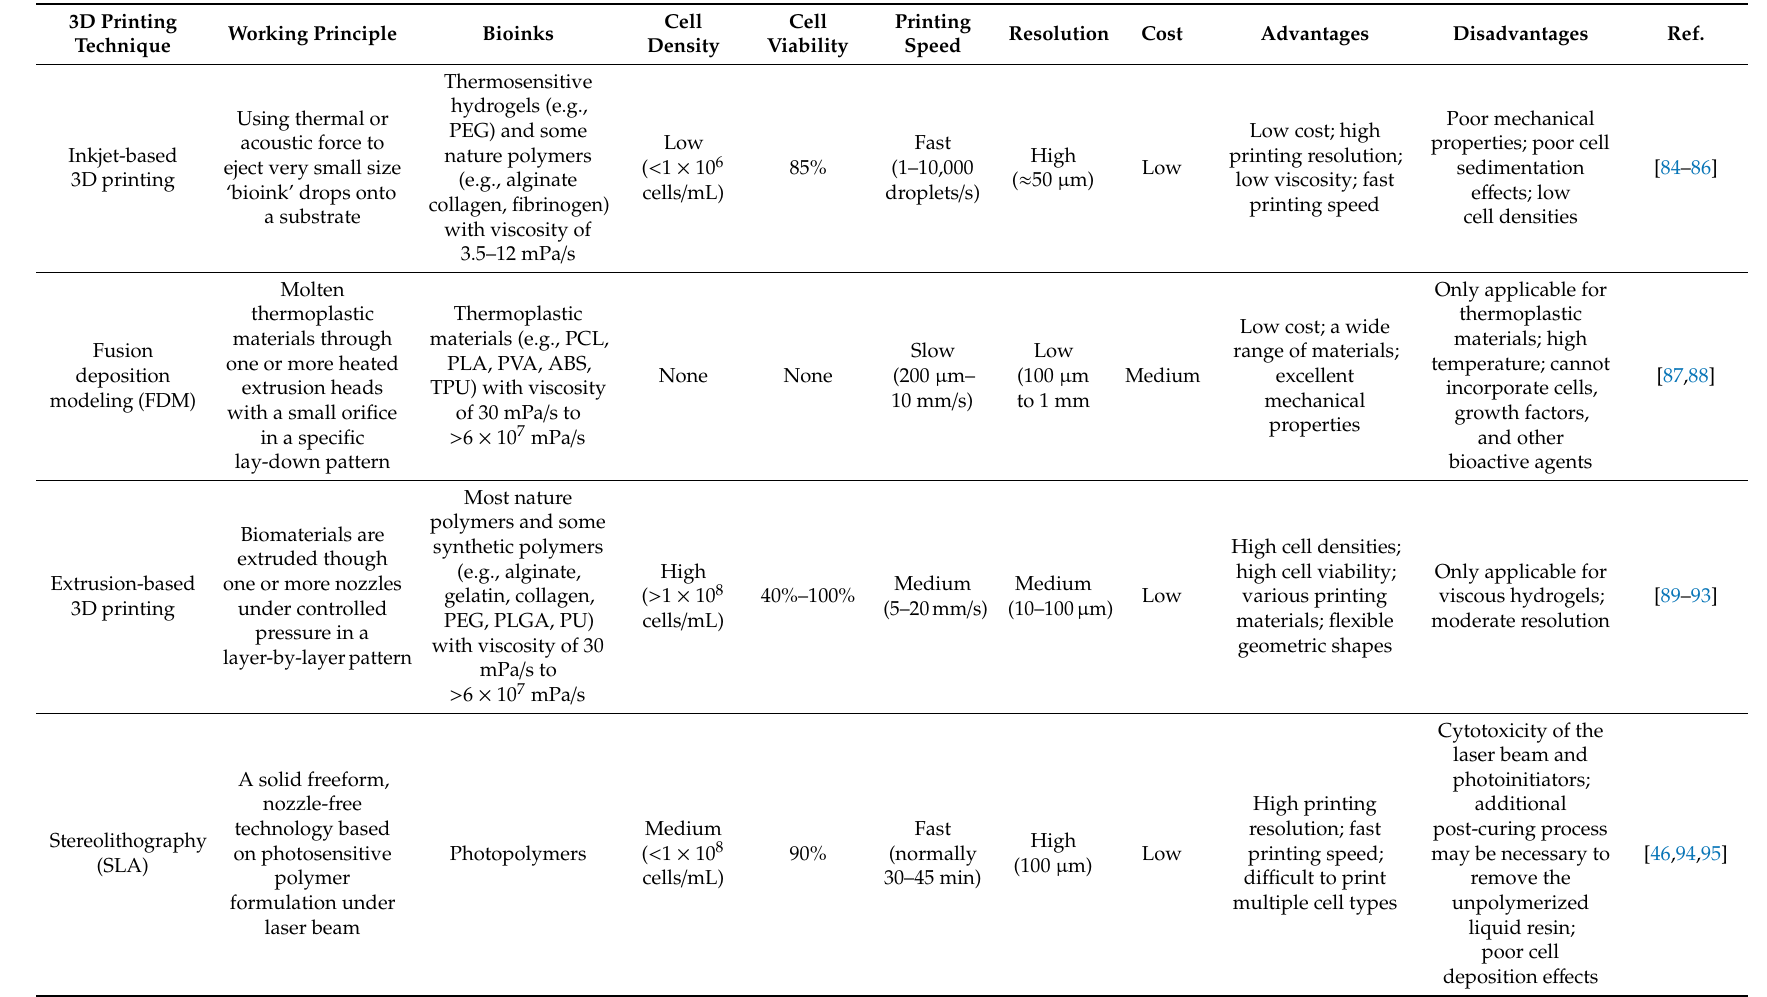
Table 1. Comparison of 3D printing technologies for bioartificial organ